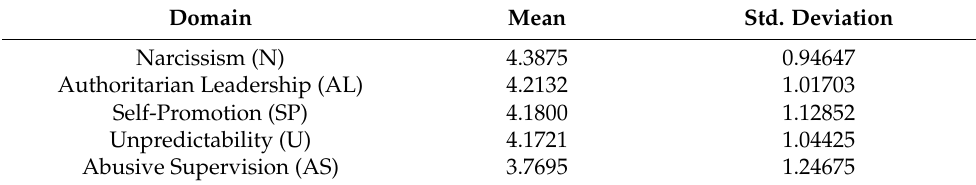
Table 2. Descriptive statistics for toxic leadership across 5